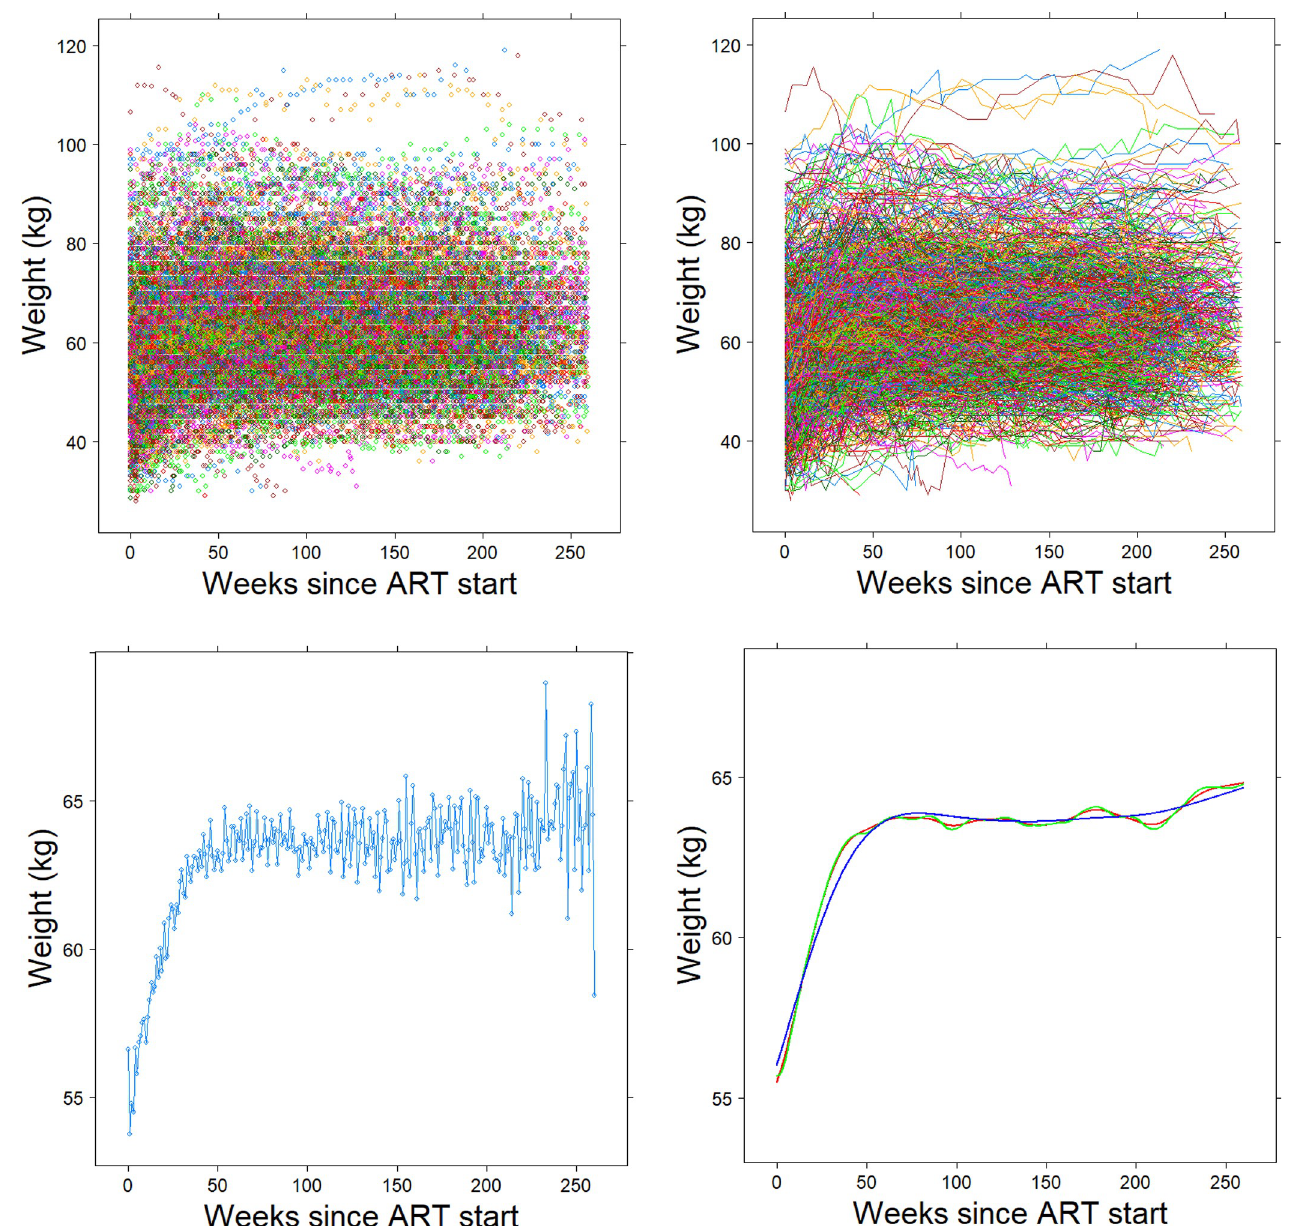
Fig 1. Four different visualizations of weight changes t (kg) after antiretroviral therapy initiation in involving data from 1% of HIV-infected patients from the IeDEA database (2,000 patients, 46,207 observations). The upper-left panel (a) represents a scatter plot; the upper-right panel (b) shows a spaghetti plot; the lower-left panel includes a plot of the mean weight over time; Lower-right panel represents smooth curves estimated at 3 different smoothing parameter values.